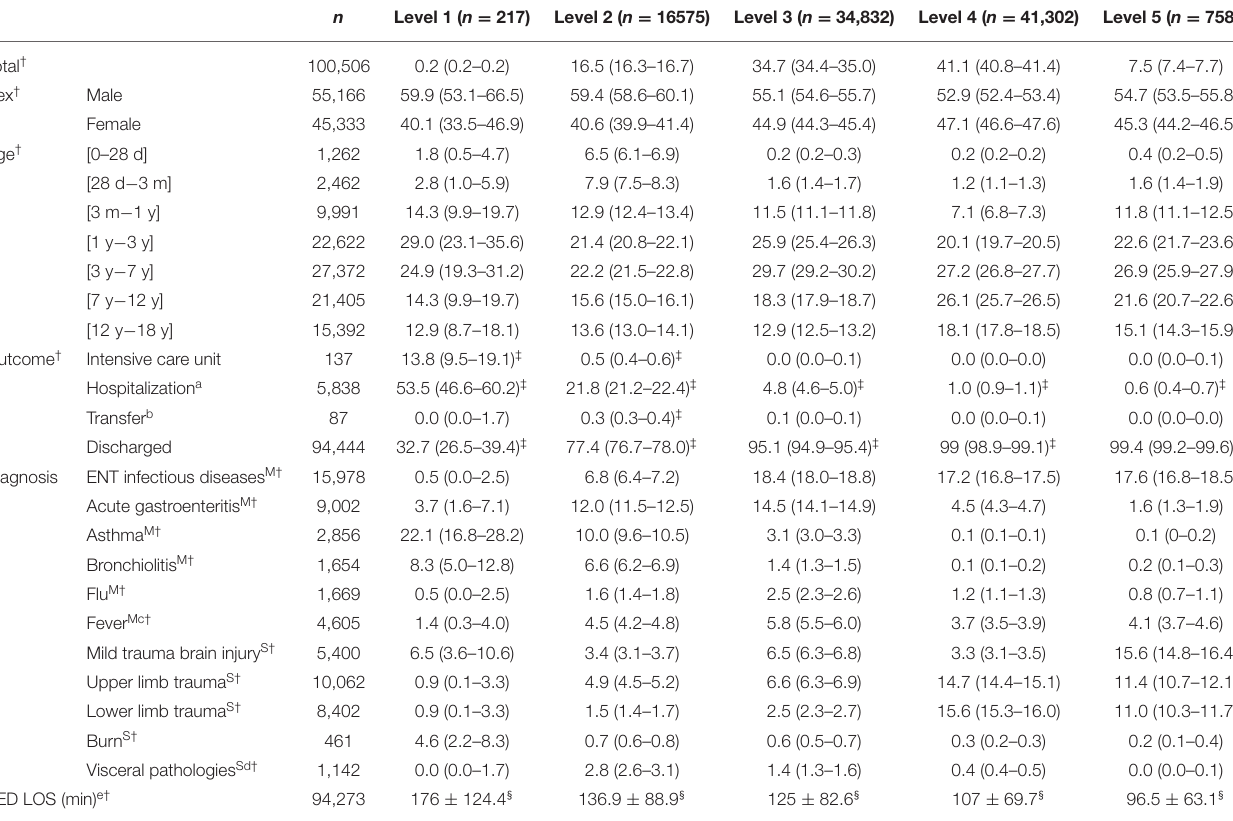
TABLE 1 | Characteristics of the sample by level of